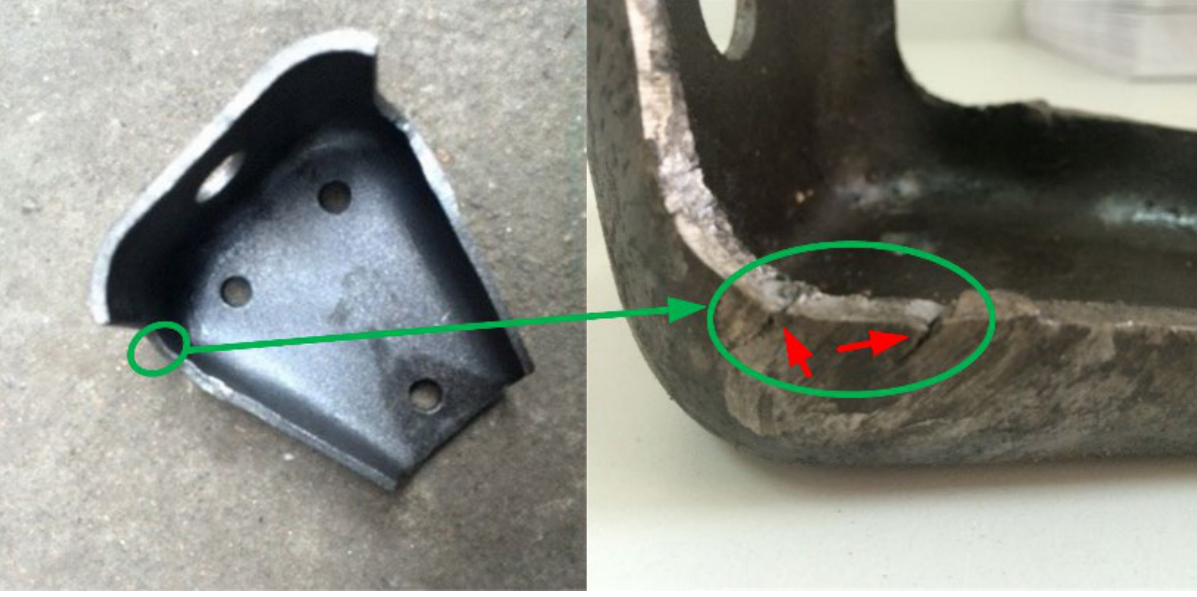
Figure 1. Phenomenon of sheared-edge cracking in the supporting frame part.